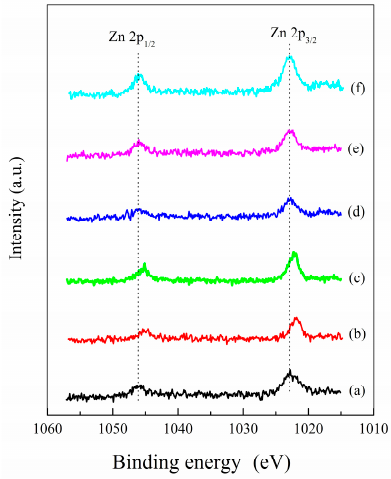
Figure 6. XPS spectra of the Zn 2p regions for fresh, deactivated, and regenerated catalysts. ( a ) Co-Zn/H-Beta-F, ( b ) Co-Zn/H-Beta-D, ( c ) Co-Zn/H-Beta-R (H 2 + O 2 , 450 ◦ C), ( d ) Co-Zn/H-Beta-R (O 2 + H 2 , 450 ◦ C), ( e ) Co-Zn/H-Beta-R (O 2 + H 2 , 500 ◦ C), ( f ) Co-Zn/H-Beta-R (O 2 + H 2 , 550 ◦ C).